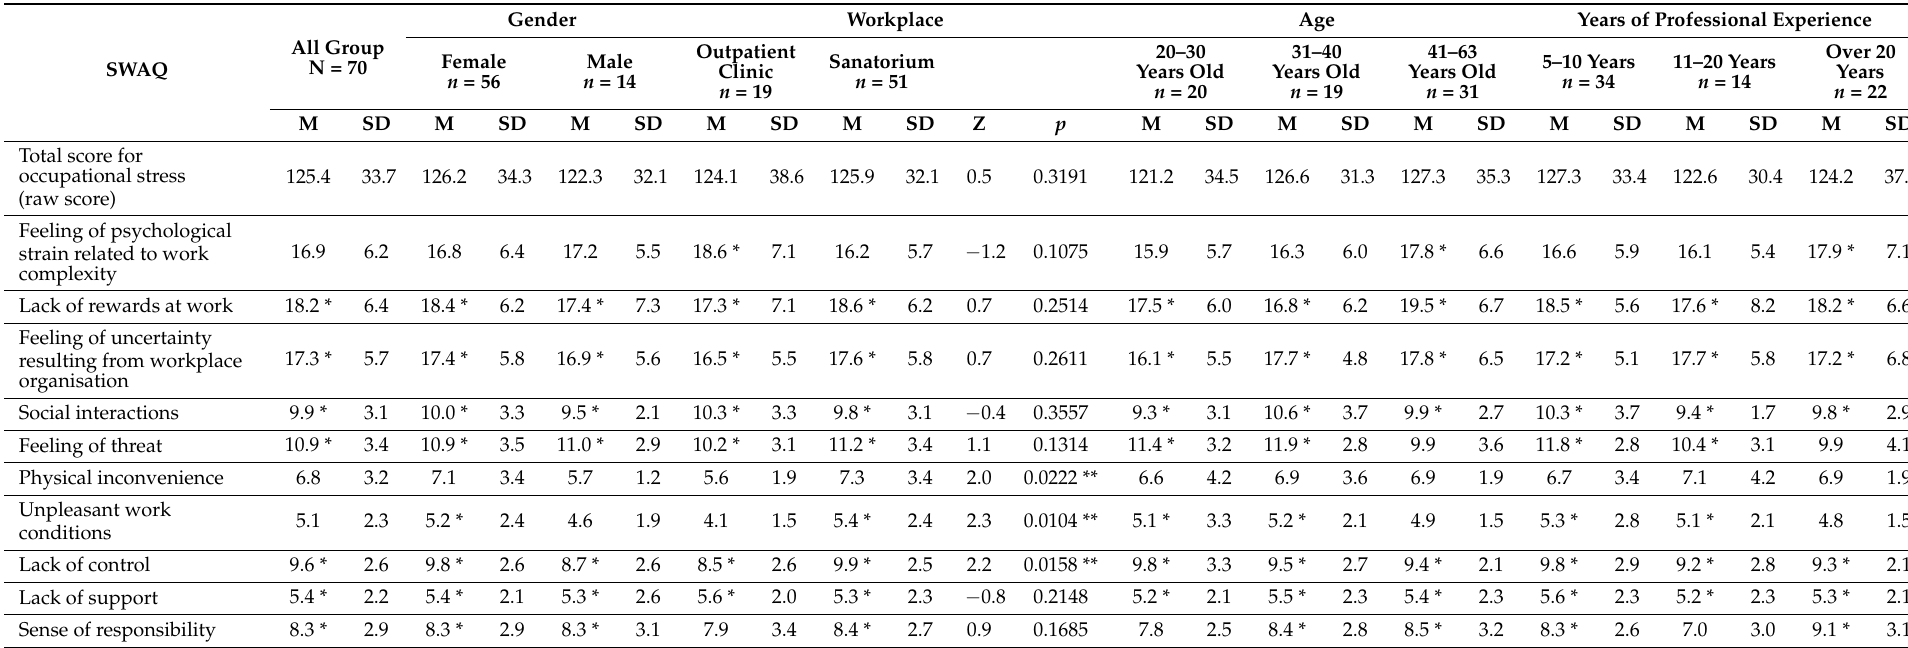
Table 4. The SWAQ results in the all study group and in selected subgroups (the Mann–Whitney U